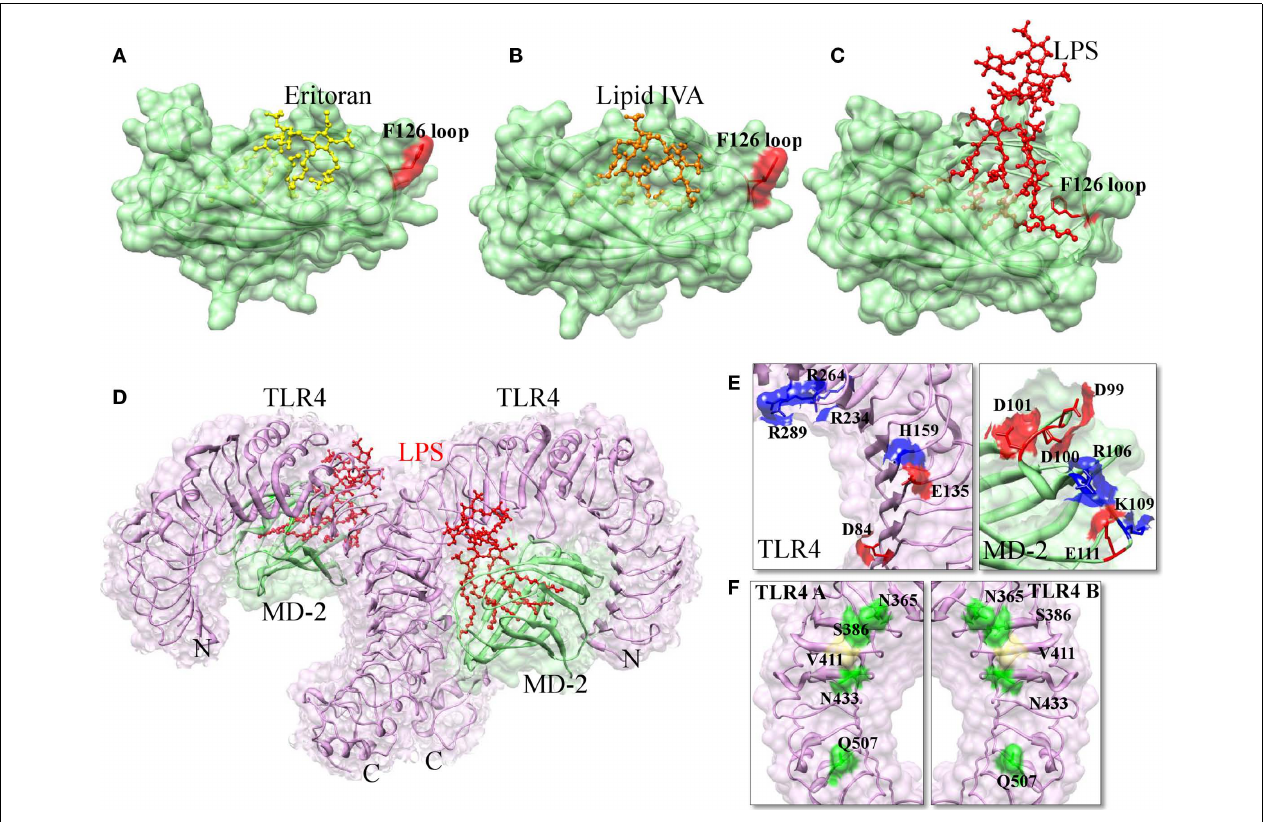
as well asTLR4 dimerization to occur. (D) Structure ofTLR4–MD-2–LPS complex.TLR4, MD-2, and LPS are colored in magenta, light green, and red, respectively. (E) TLR4–MD-2 dimer interface formed by electrostatic interaction. Positive and negative charged residues are marked in blue and red color, respectively. (F) TLR4 homodimer interface. Hydrophilic and hydrophobic residues are colored in green and khaki,